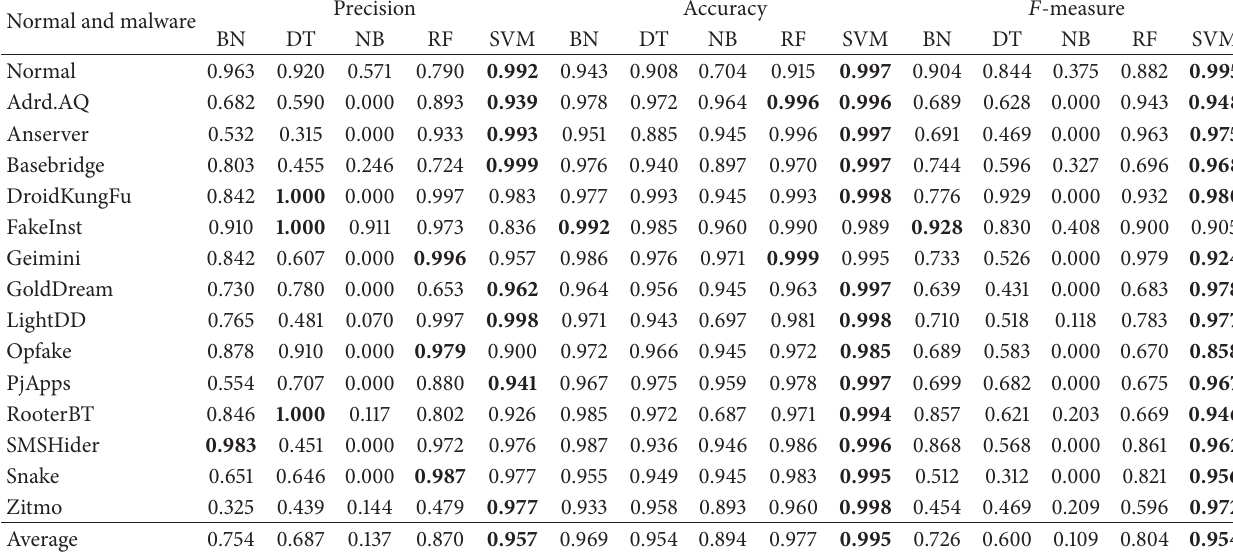
Table 6: Detailed performance indicators of machine learning classifiers (precision/accuracy/ 𝐹